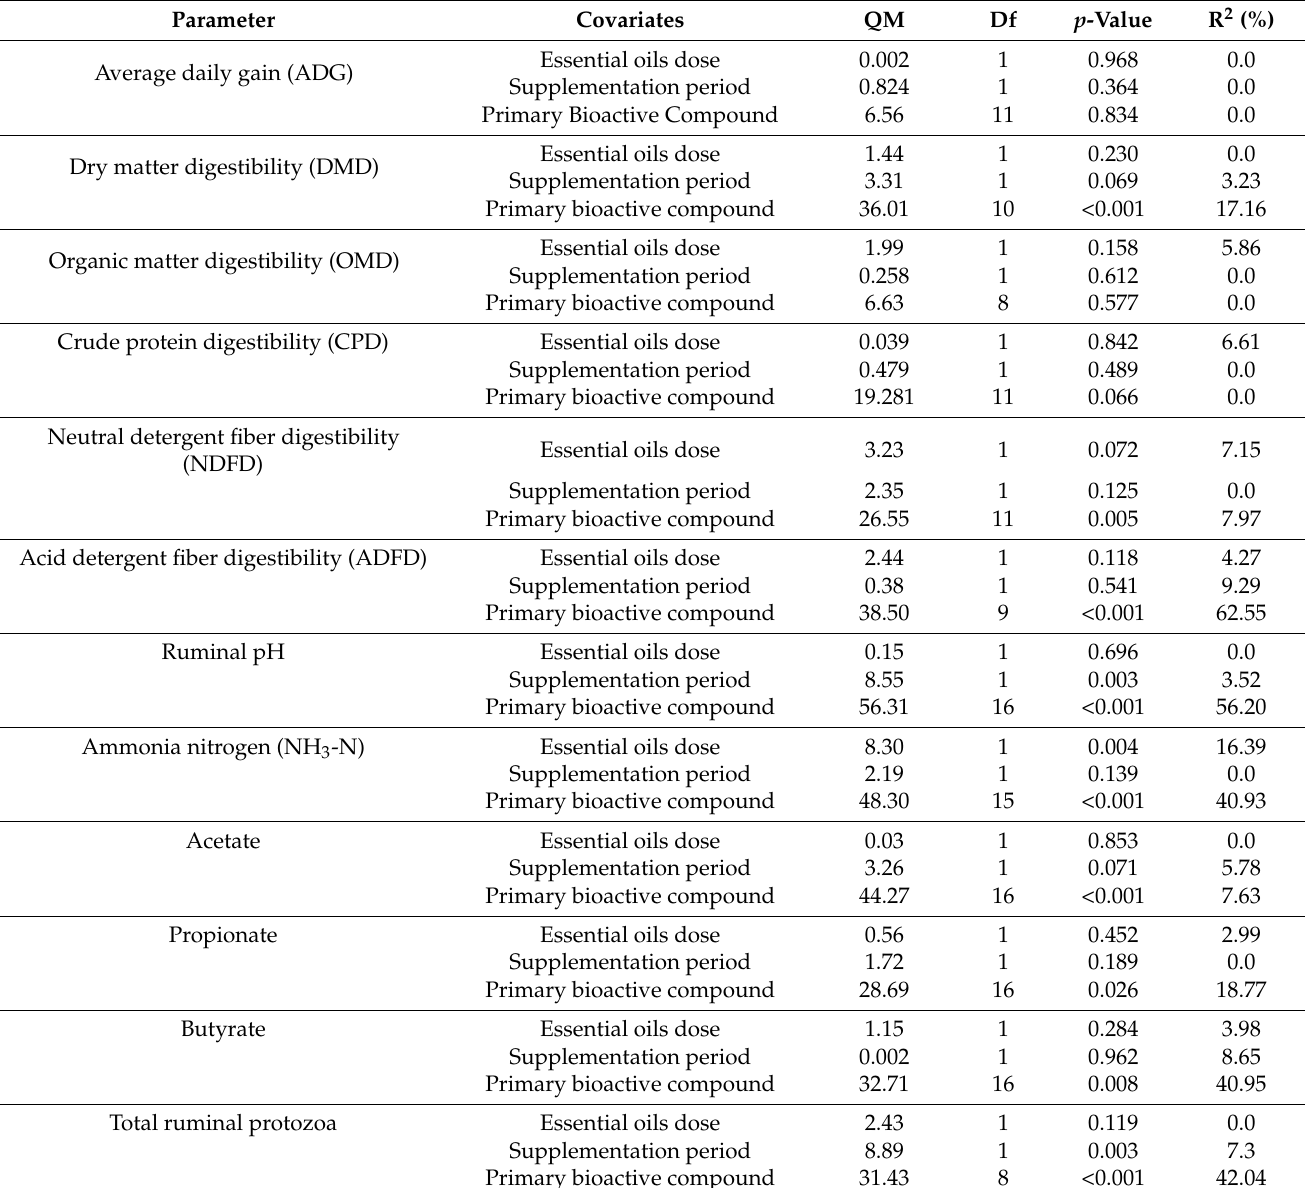
Table 8. Meta-regression comparing the associations between covariates and measured